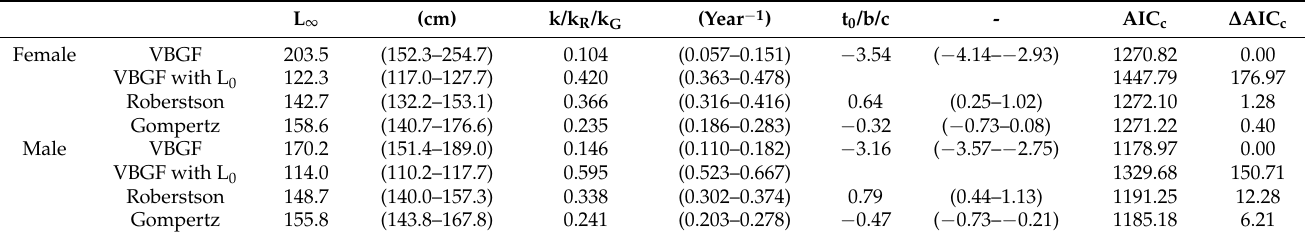
Table 2. Growth parameters of spot-tail sharks estimated from three growth